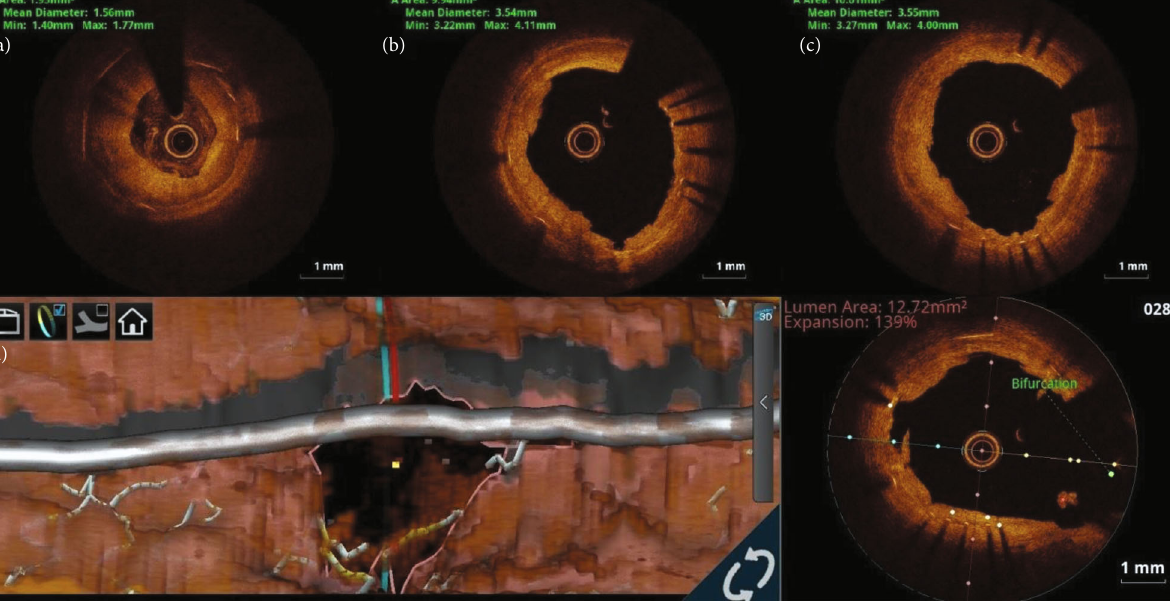
Figure 4: OCT images of PCI optimization. Initial OCT run showed di ff use neointimal hyperplasia with LMCA MSA of 1.93m 2 (a). Final OCT run showed MSA at proximal LMCA and ostial LAD as 9.94mm 2 and 10.01 mm 2 , respectively (b, c). OCT 3D bifurcation mode (ILUMIEN ™ Optis ™ System — Abbott Vascular) showed adequate LCX ostial area (d).